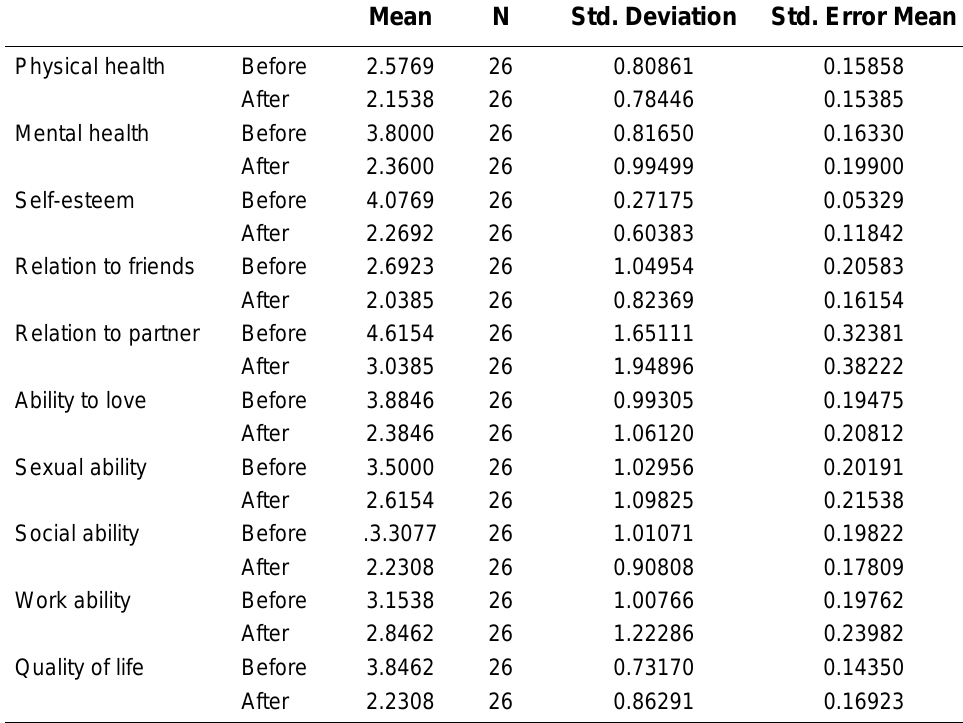
Study of 26 Patients Who’s Ratings of Self-Esteem (Feelings about Themselves) were Changed with Therapy from Bad to Not Bad* Mean N